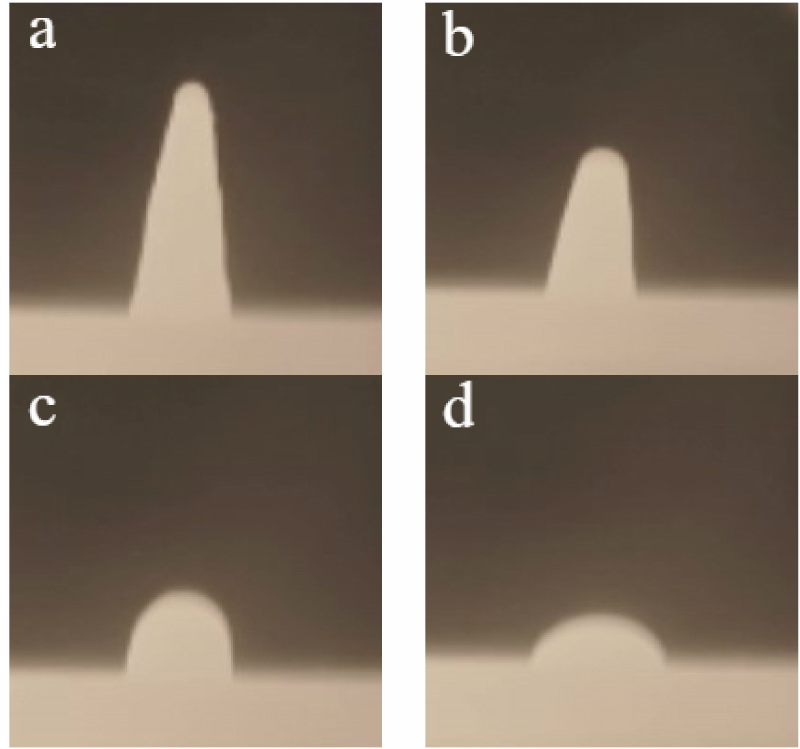
Figure 4. The changing shape of a sample during heating. The four transition temperatures: ( a ) de- formation, ( b ) softening, ( c ) hemispherical fusion, ( d )